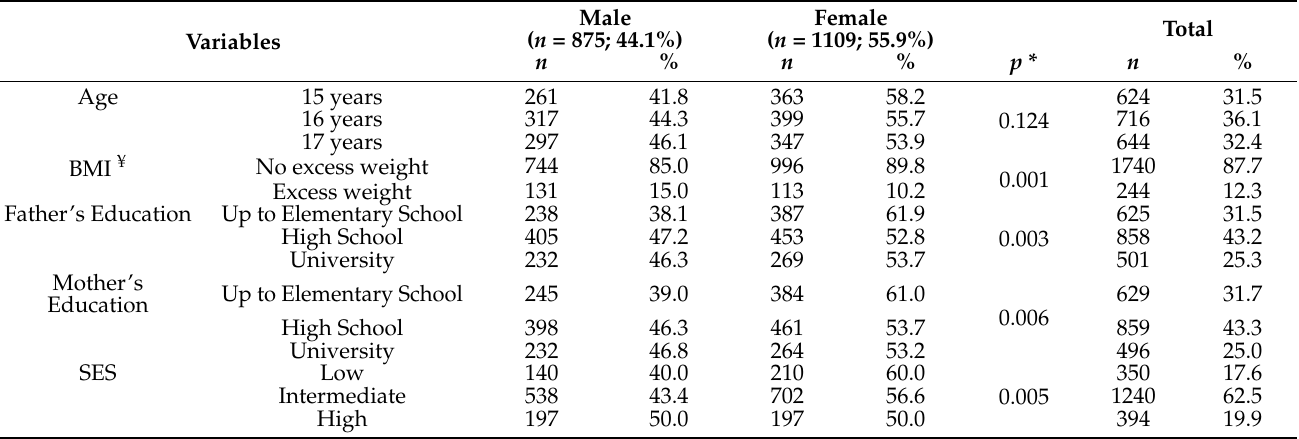
Table 1. Description of the sociodemographic characteristics of the adolescents from public schools ( N =